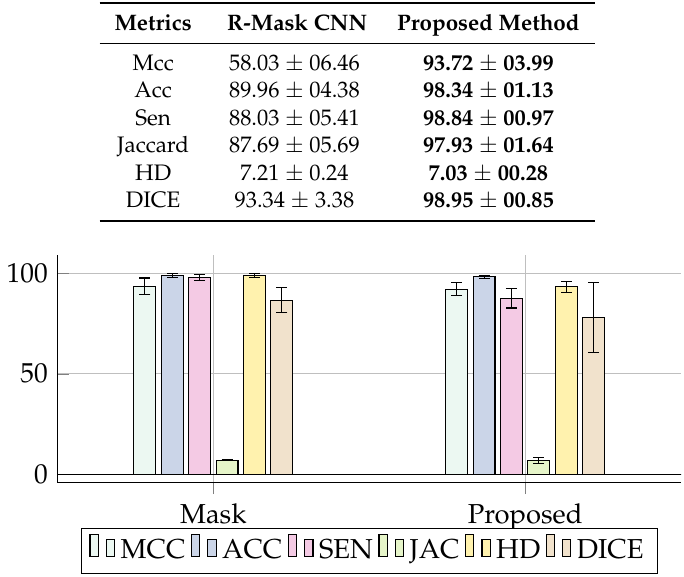
Figure 7. Illustration of the metrics obtained with the result of the Mask R-CNN against the output generated by the proposed